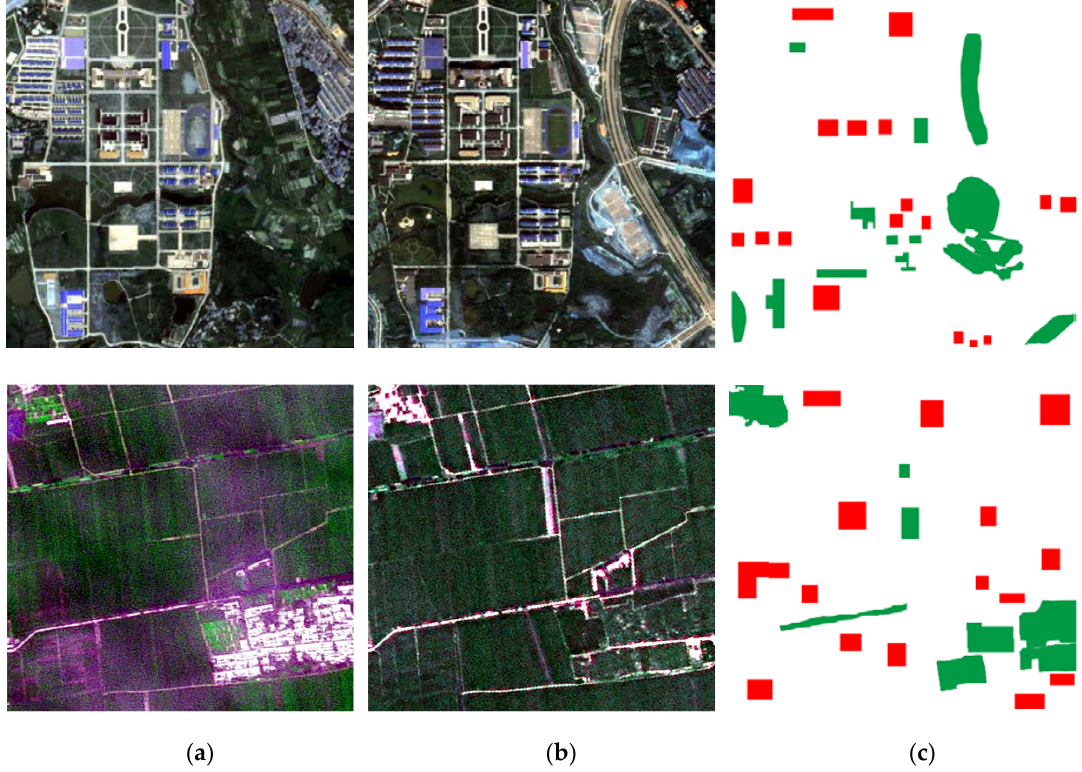
Figure 5. The data set in the experiments. ( a , b ) are the images acquired at T 1 and T 2 , respectively. ( c ) denotes the reference maps.